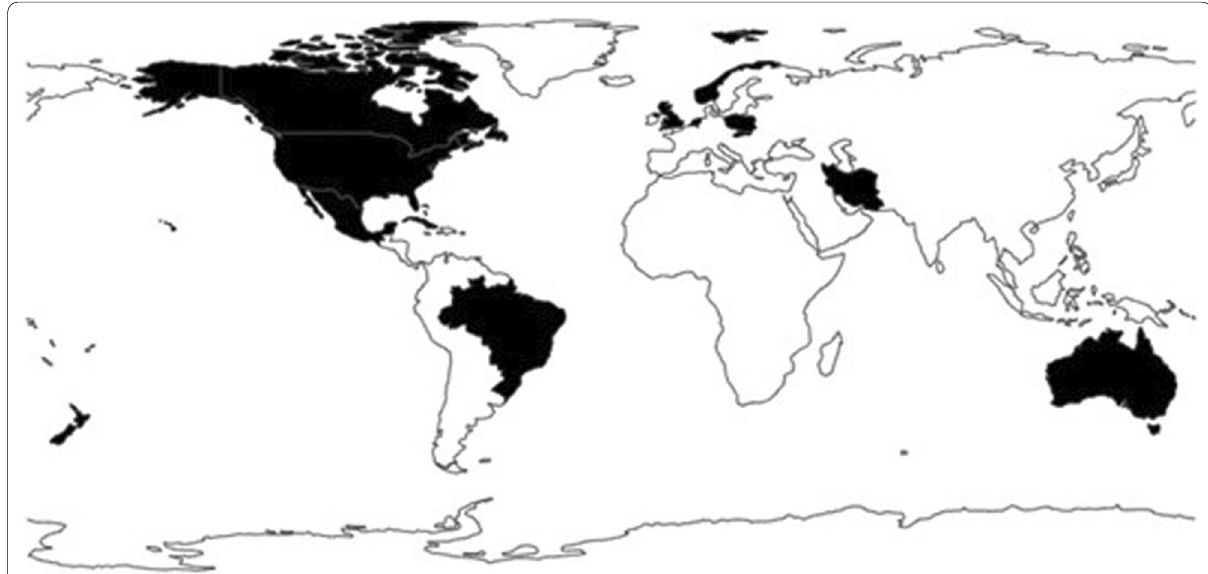
Fig. 2 Geographic distribution of participants of the